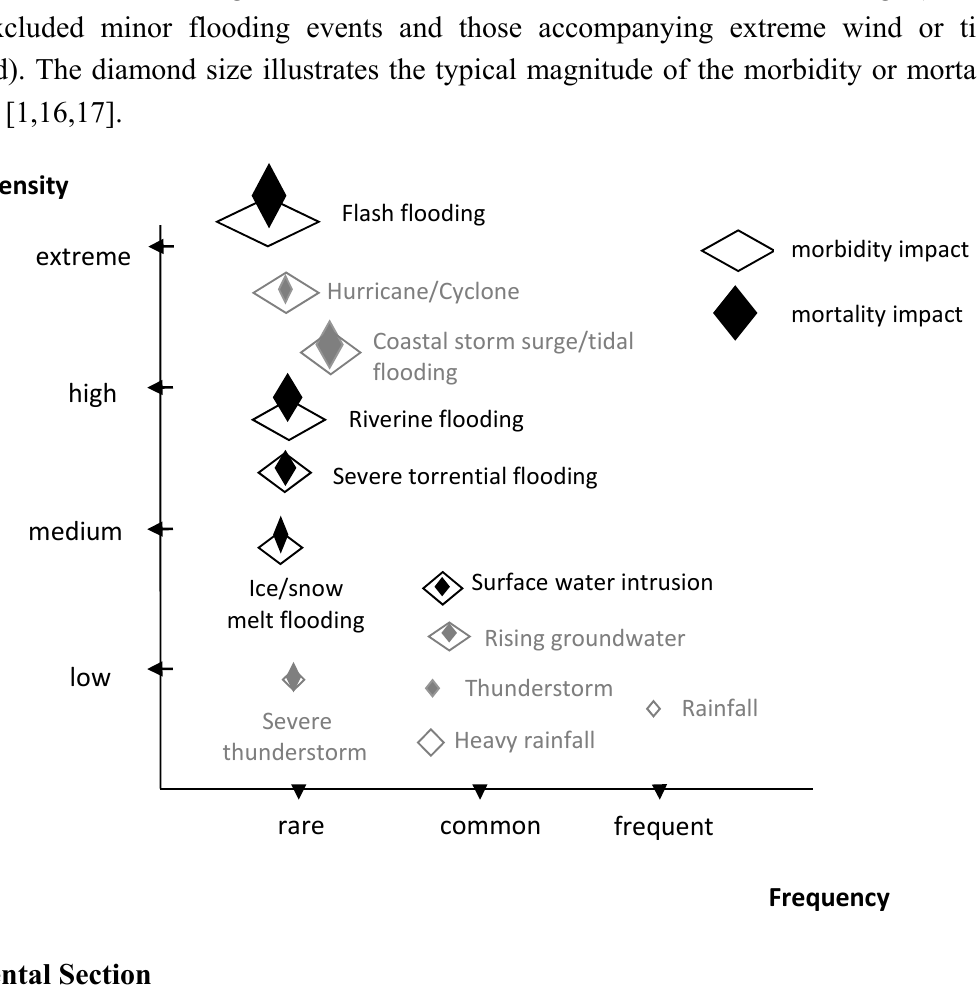
Figure 2. Severity, frequency and impact of extreme hydrological weather